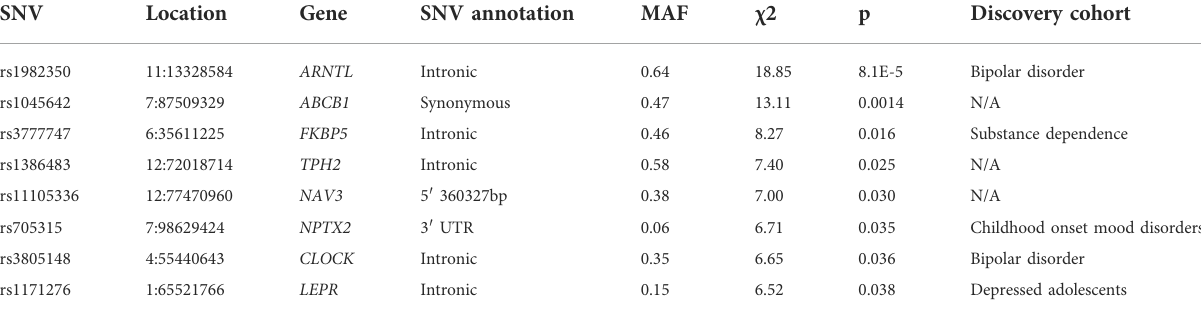
TABLE 3 SNVs associated with history of suicide